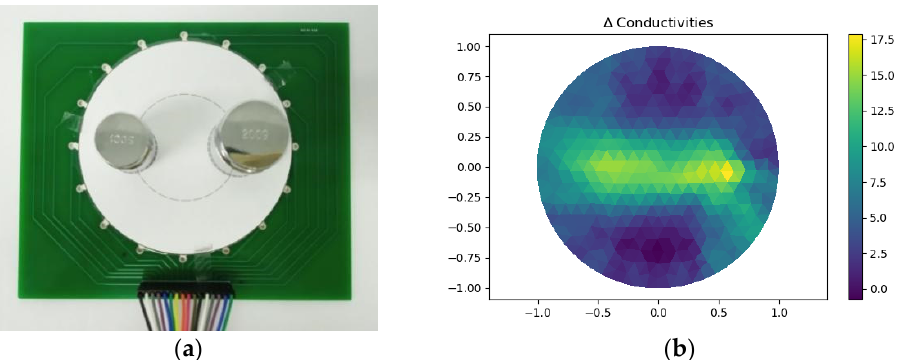
Figure 19. Different pressure loading under multi-object: ( a ) Setup of experiment; ( b ) Reconstructed image.